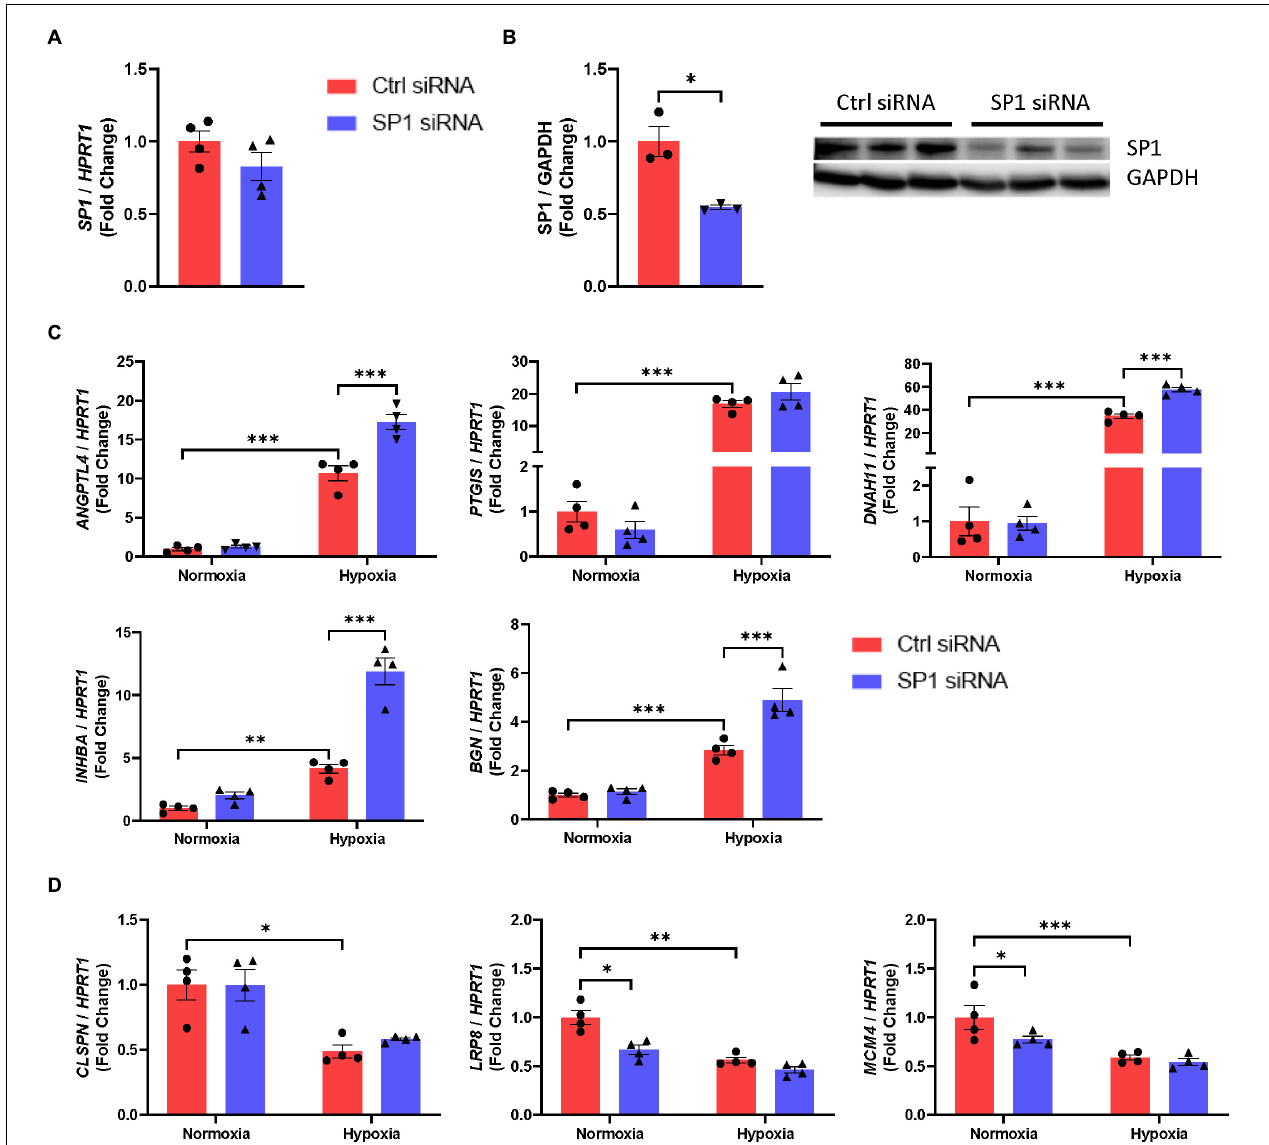
FIGURE 2 | SP1 differentially regulates hypoxic gene expression in ECs in vitro . (A) SP1 mRNA levels in HUVECs after 24 h of hypoxia were detected via qPCR ( n = 4). (B) SP1 protein levels in HUVECs after 24 h after siRNA transfection were detected by Western blot ( n = 3). For each sample, 20 µ g of protein were loaded onto polyacrylamide gels. Chemiluminescence with an exposure time of 390 s (SP1) or 120 s (GAPDH). (C) mRNA levels of genes, which were upregulated under hypoxia, were detected using qPCR after siRNA-mediated SP1 -knockdown in combination with hypoxia ( n = 4). (D) mRNA levels of genes, which were downregulated under hypoxia, were detected using qPCR after siRNA-mediated SP1 -knockdown in combination with hypoxia ( n = 4). Each dot resembles the mean value of all technical replicates from an independent experiment. ∗ p ≤ 0.05, ∗∗ p ≤ 0.01, ∗∗∗ p ≤ 0.001.